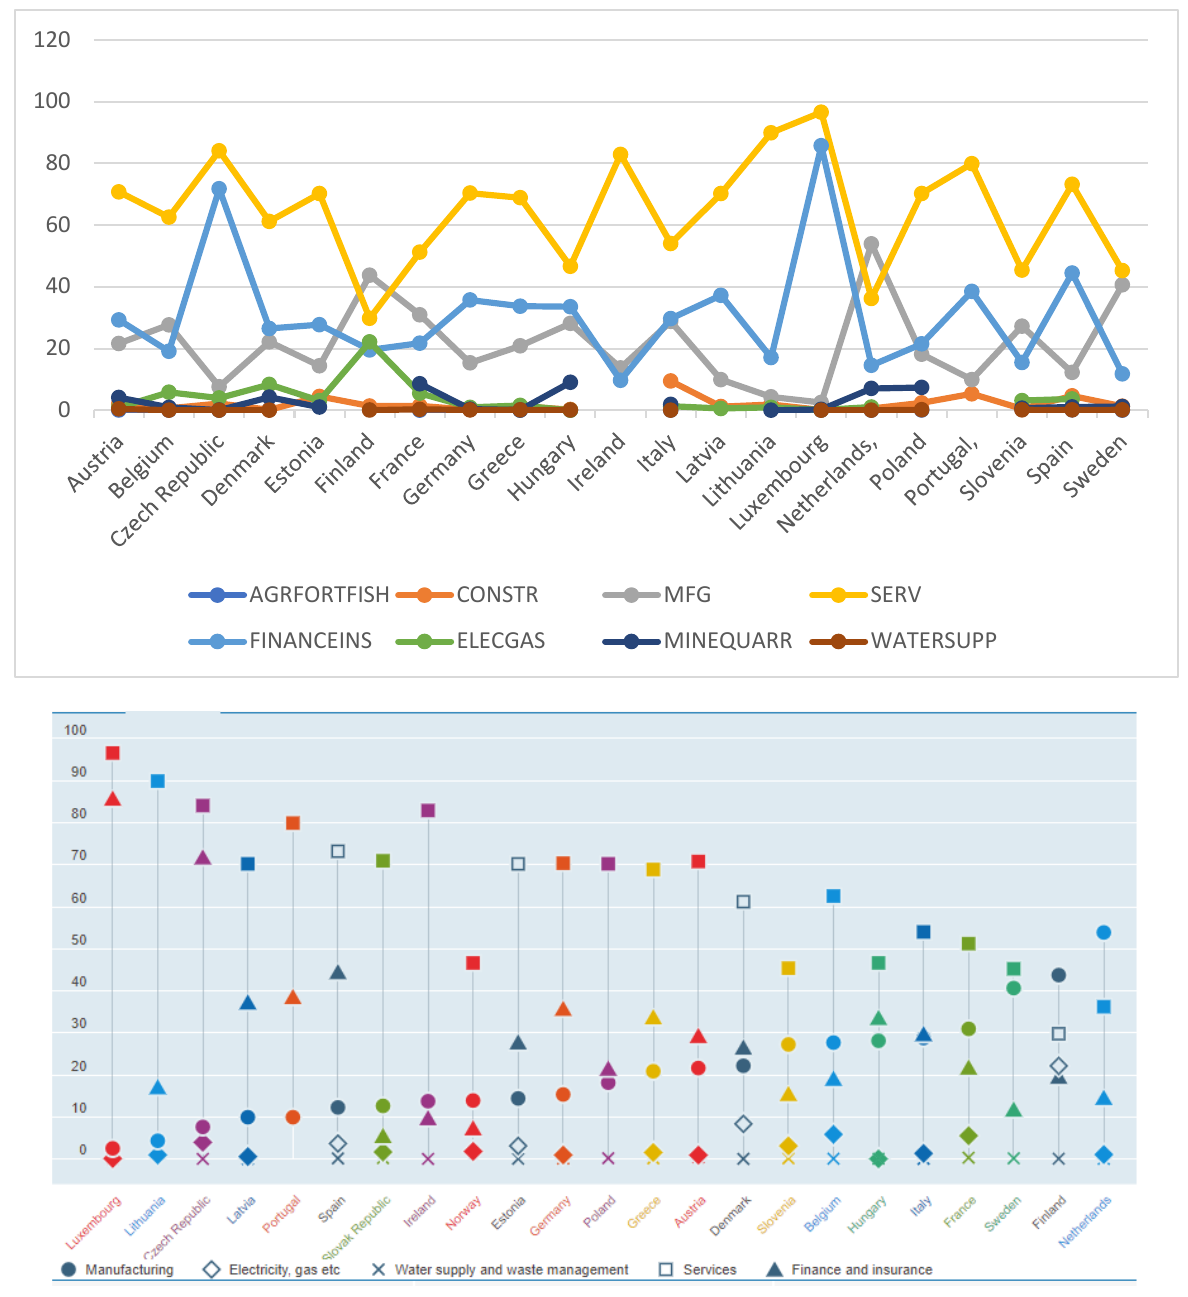
Figure 2. Source: Benchmark definition, 4th edition (BMD4): Foreign direct investment: positions by industry. OECD (2022), Outward FDI stocks by industry (indicator). Doi:10.1787/db70d1c4-en (accessed on 1 February 2022).